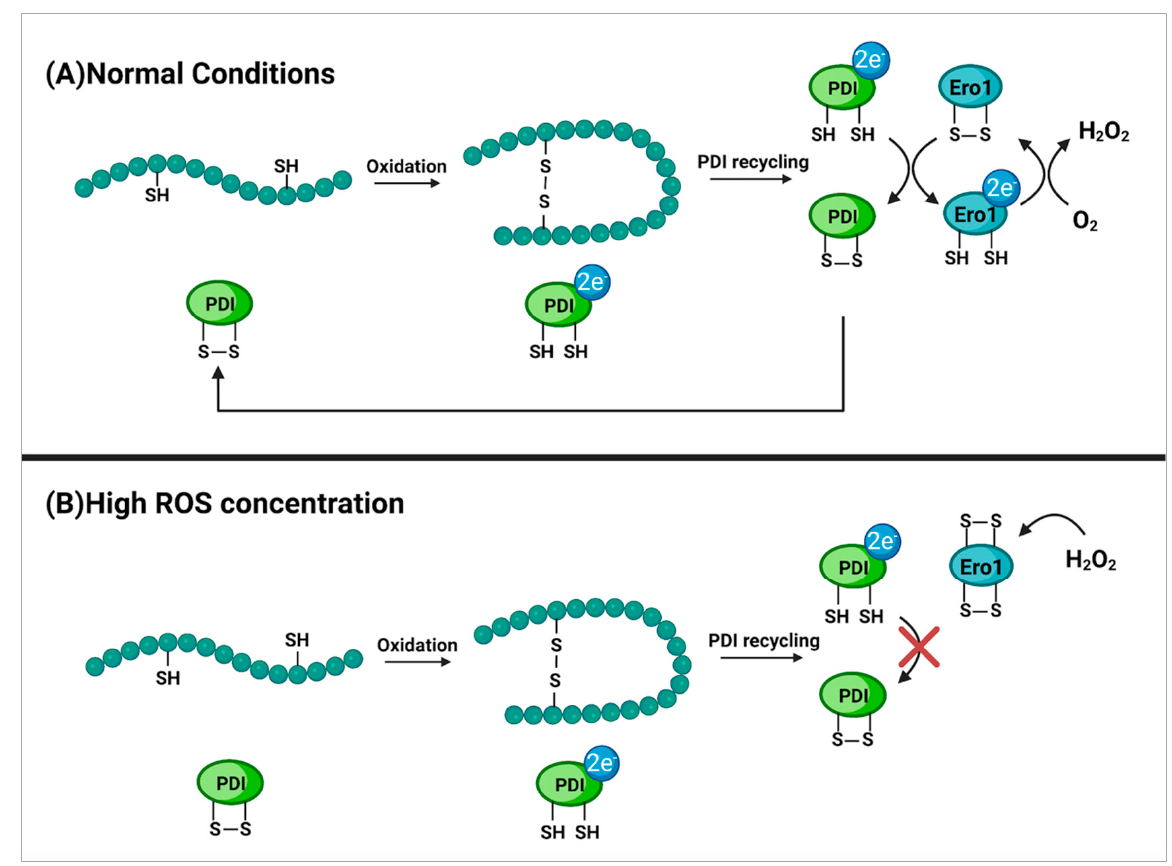
Figure 8. Cysteine oxidation of Ero1 as a protection mechanism. ( A ) displays the formation of disulfide bridges within proteins bound for the extracellular environment. This takes place in the endoplasmic reticulum of the cell and is mediated by the protein disulfide isomerase (PDI). Upon disulfide bridge formation, PDI is reduced and must transfer its electrons to the disulfide oxidase enzyme endoplasmic reticulum oxireductin 1 (Ero1) in order to return to its active state. The now reduced Ero1 then transfers electrons to a terminal acceptor oxygen which returns Ero1 to its active state and forms H 2 O 2 as a byproduct [93]. ( B ) shows the formation of intramolecular disulfide bridges between cysteines within Ero1 due to high concentrations of H 2 O 2 . This inhibits regular activity of Ero1 which then in turn prevents the recycling of PDI and therefore the formation of disulfide bridges within proteins. This serves as a protection mechanism to prevent the over-production of reactive oxidative species (ROS) during times of oxidative stress in order to protect the cell from damage